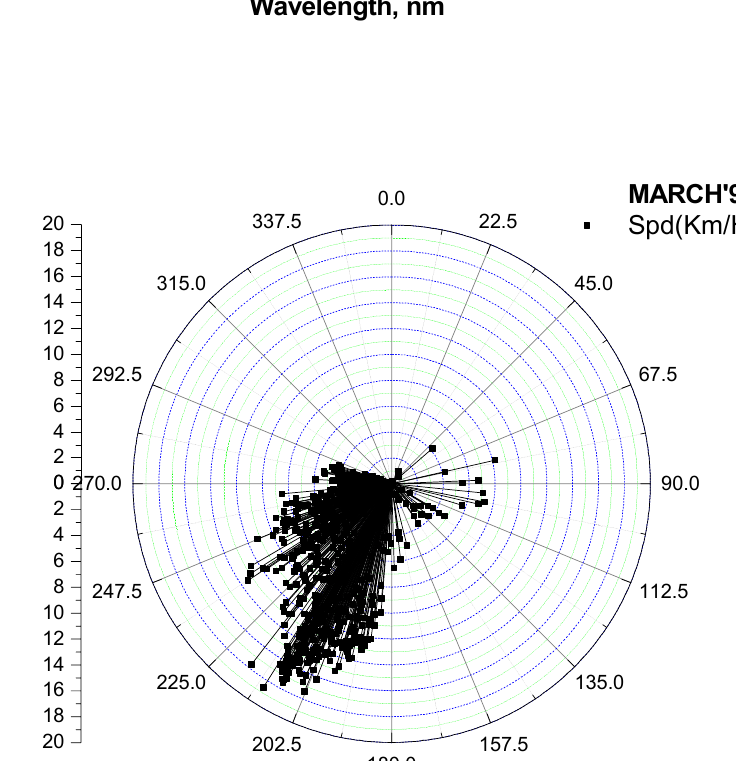
cal depths show near Junge spectral properties as shown in Fig. 5. The top panel shows the mean spectral variation of the AOD during that month, while the bottom panel shows the mean wind speed and direction for the days considered in the study. However, during the summer, the wind is pre- dominantly from the south/southwest. In Fig. 6 the spectral variation of aerosol optical depths are shown when the